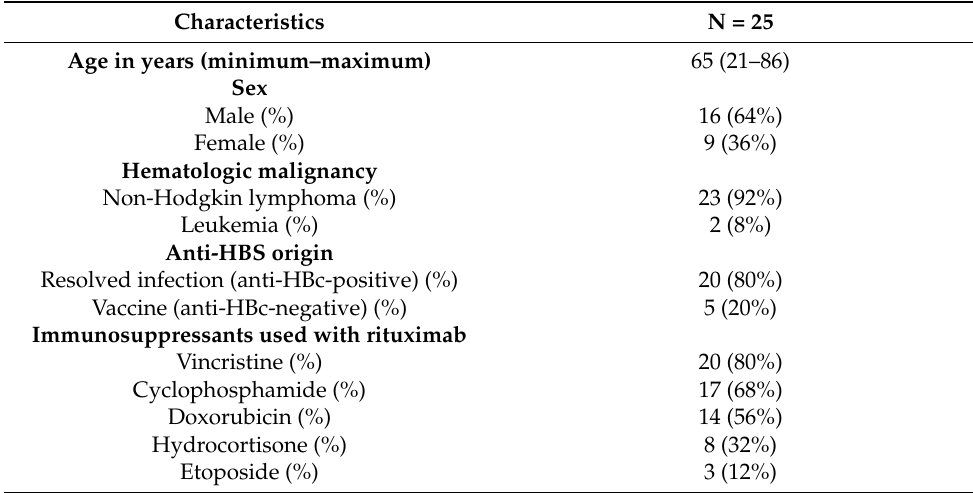
Table 1. Baseline characteristics of anti-HBs kinetics group.